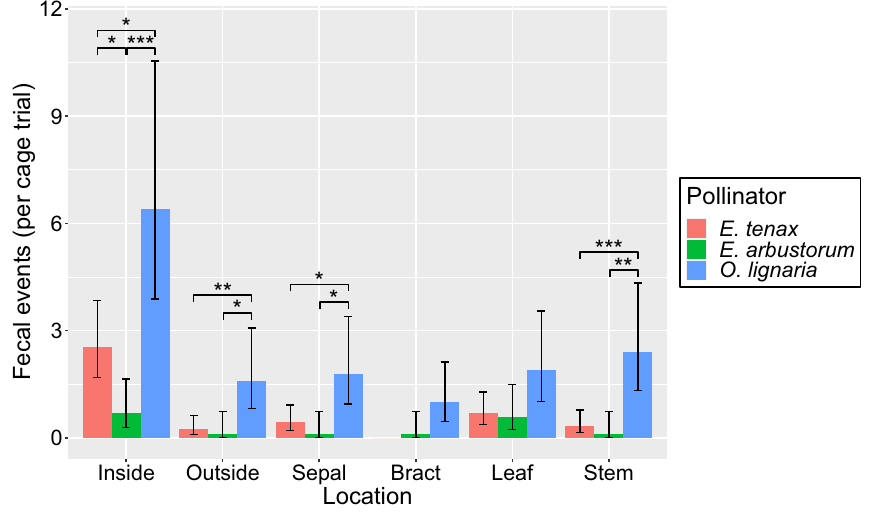
Figure 4. Number of Eristalis tenax , Eristalis arbustorum and Osmia lignaria fecal events per cage trial ( n = 10 each) at six different floral locations (inside the corolla, outside the corolla, on the sepal, bract, leaf or stem) of Solidago dansolitum ‘Little Lemon’ goldenrod. Asterisks indicate Tukey-corrected significance of pairwise contrasts between species within each location (***p < 0.001; **p < 0.01; *p < 0.05). Error bars indicate 95% confidence